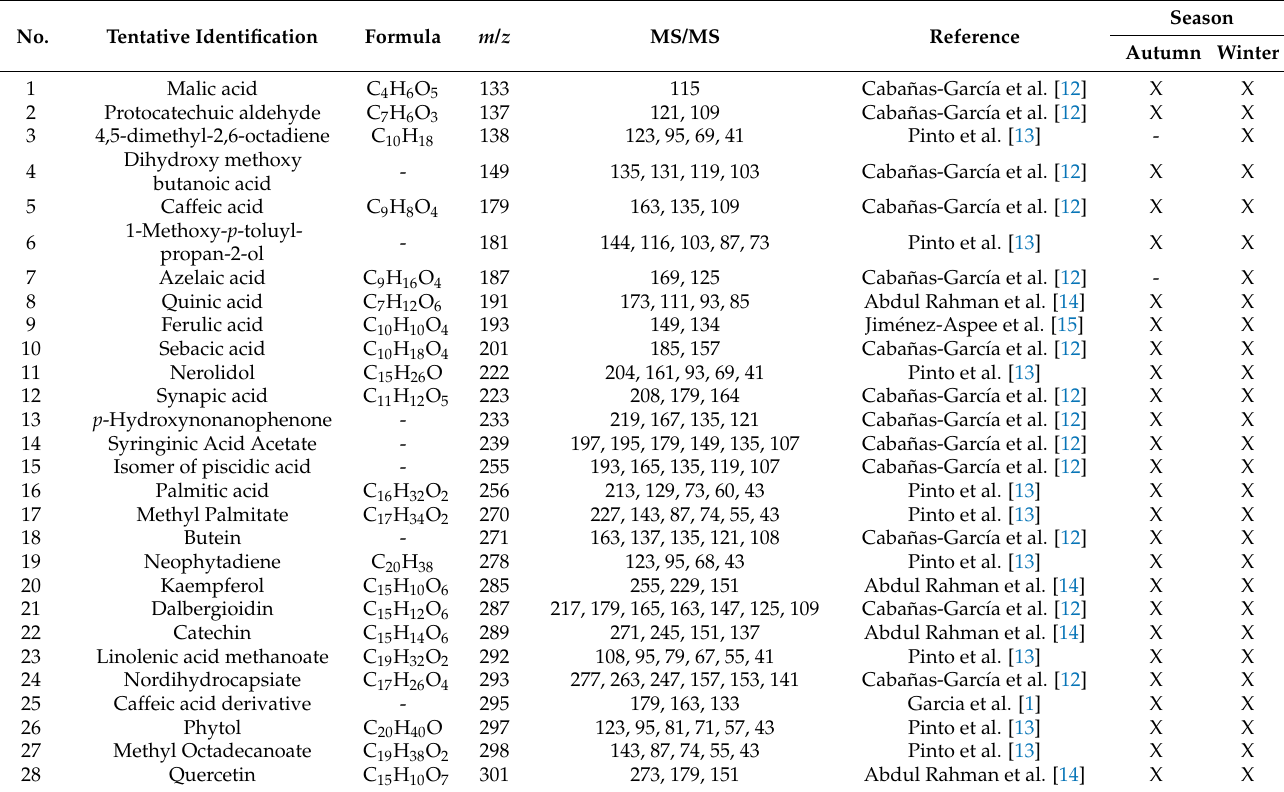
Table 1. Qualification of the chemical profile of GBB in the autumn and winter season by